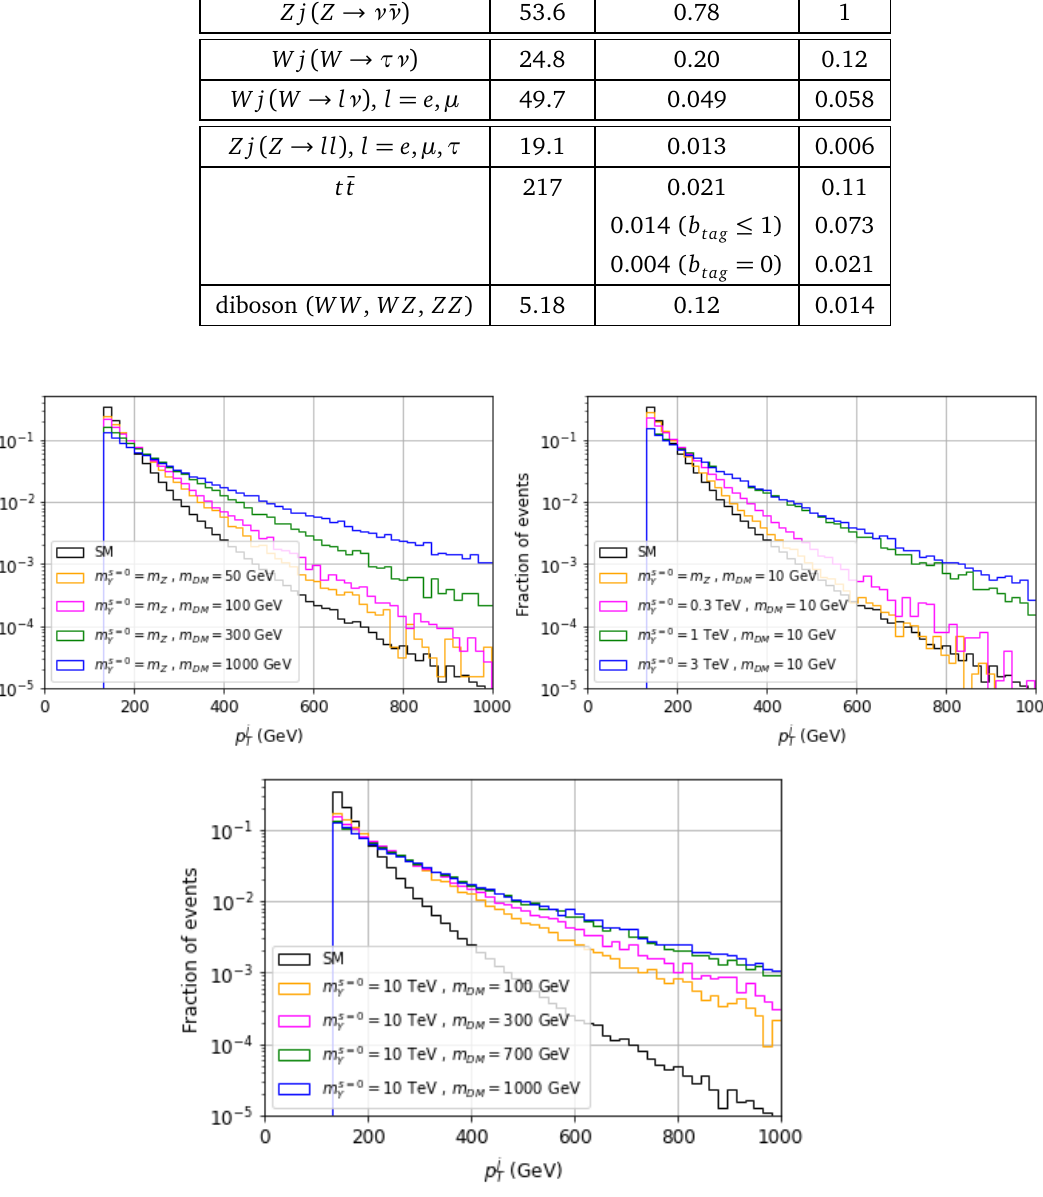
Figure 24: Space described by the p j distribution of the spin-0 mediator framework, T off-shell (top-left panel), on-shell (top-right panel), and off-shell PS (bottom panel) regime, at parton